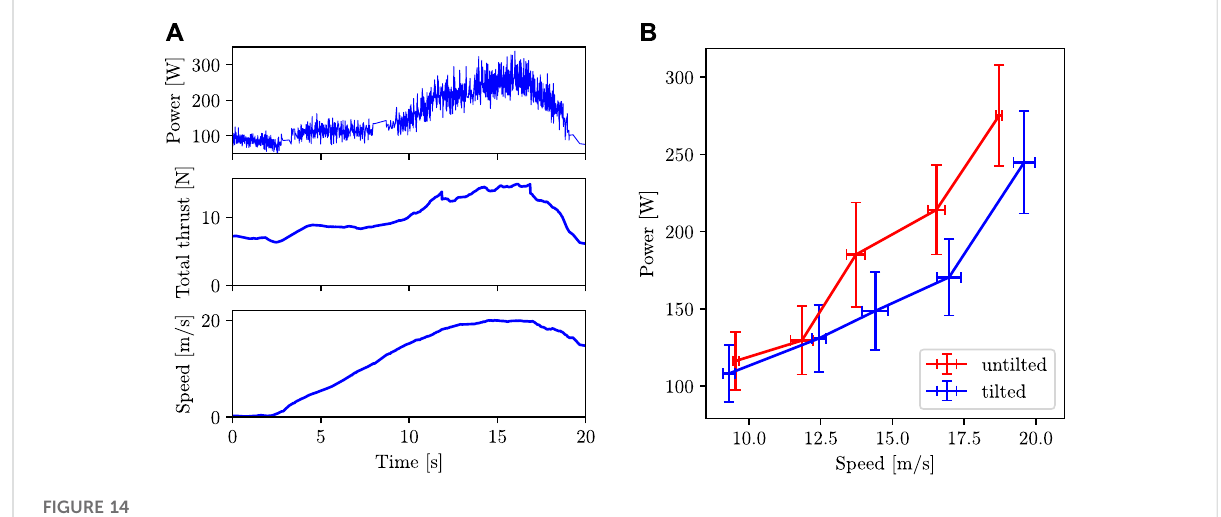
FIGURE 14 (A) Power,total thrust, and speed vstime for a single experiment. Data in this plot isfrom the experimentwherethe quadcopter is commanded to fl yin thetilted con fi guration at20 m s − 1 . (B) Powerconsumption vsspeed when fl ying in untiltedand tilted con fi gurations.The data points arethe average values and the error bars represent one standard deviation in the